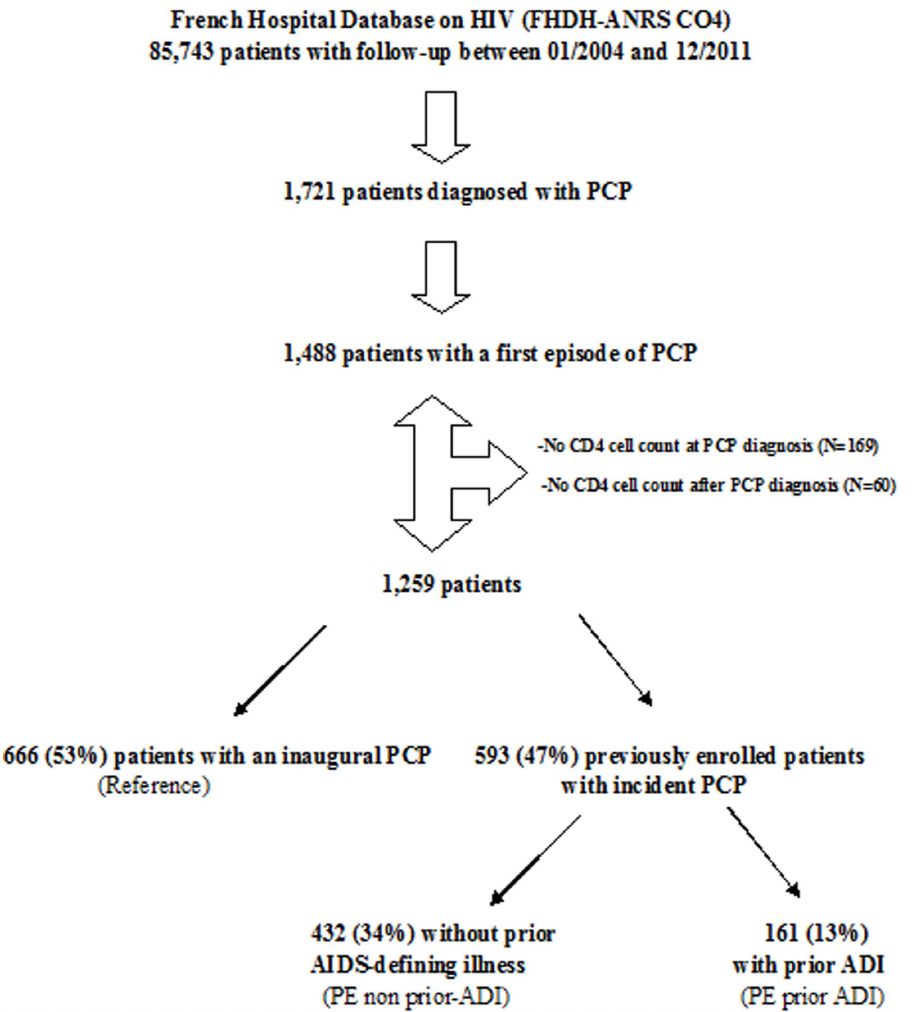
Figure 2. Patient selection flow diagram.